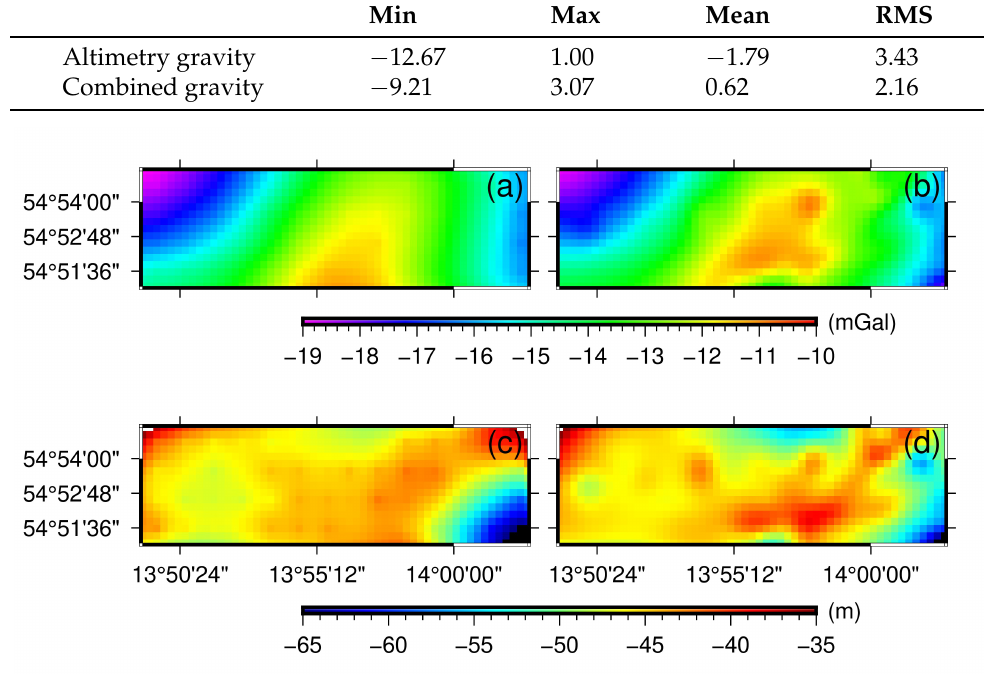
Figure A2. ( a , b ) are gravity anomalies from satellite altimetry and combined gravity anomalies, respectively. ( c , d ) are seafloor topography derived from satellite altimetry and combined gravity anomalies,